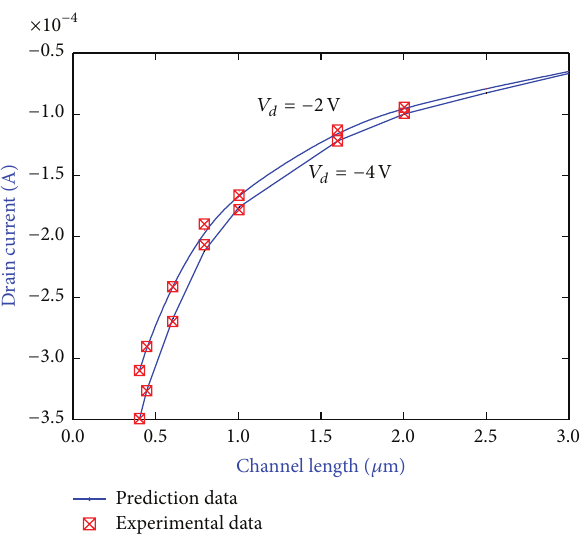
Figure 7: Comparison of 𝐼 𝑑 measured results and prediction data of the group 1B diagnostic samples (as 𝐿 = 0.5 , 1.2, 3- 𝜇 m; 𝑉 𝑔 = −3 V).